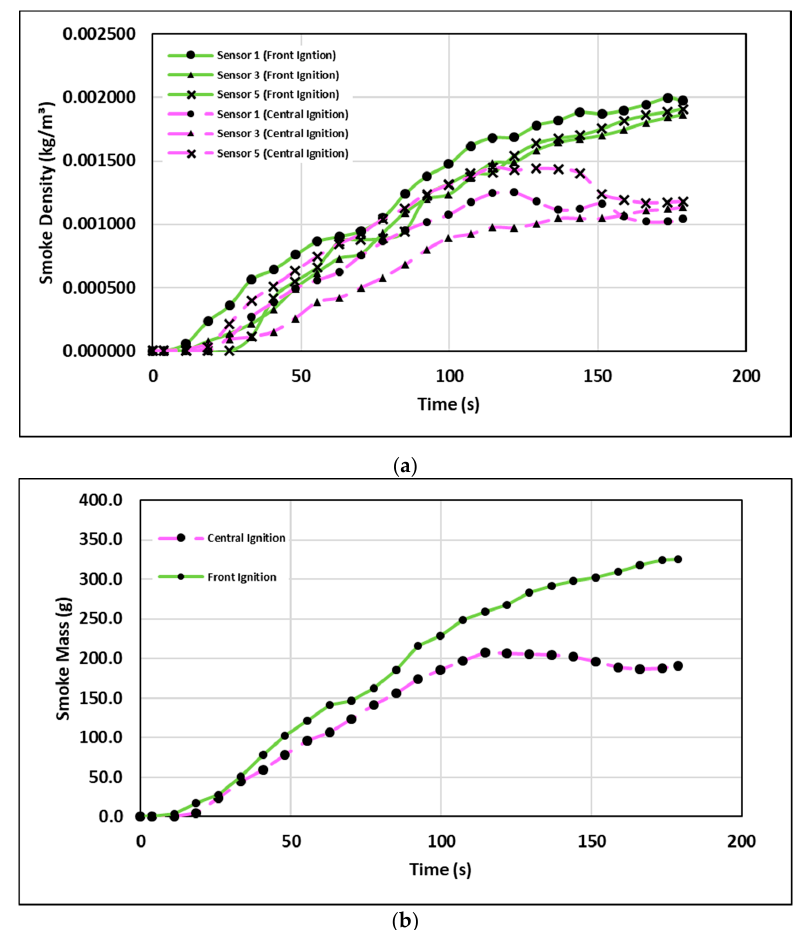
Figure 5. ( a ) Smoke density comparison for different ignition positions. ( b ) Smoke mass comparison for different ignition positions. for di ff erent ignition